Question: In one sentence, what is this figure communicating?
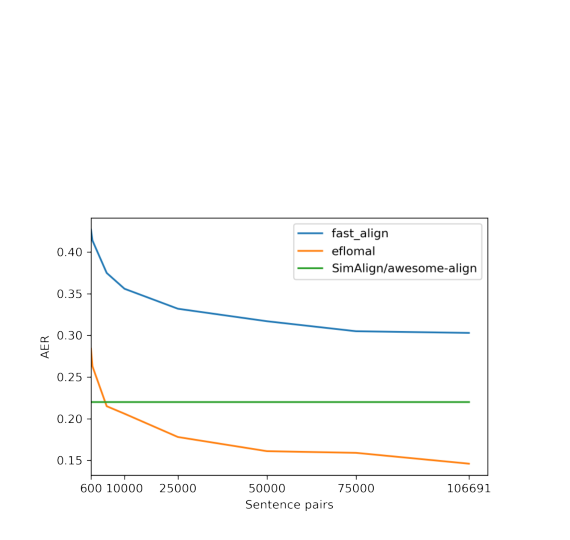
Answer: Comparison of AER between the three sys- tems (lower is better). The performance of fast_align and eflomal profits from more data. The performance of SimAlign and awesome-align is not dependent on dataset size.